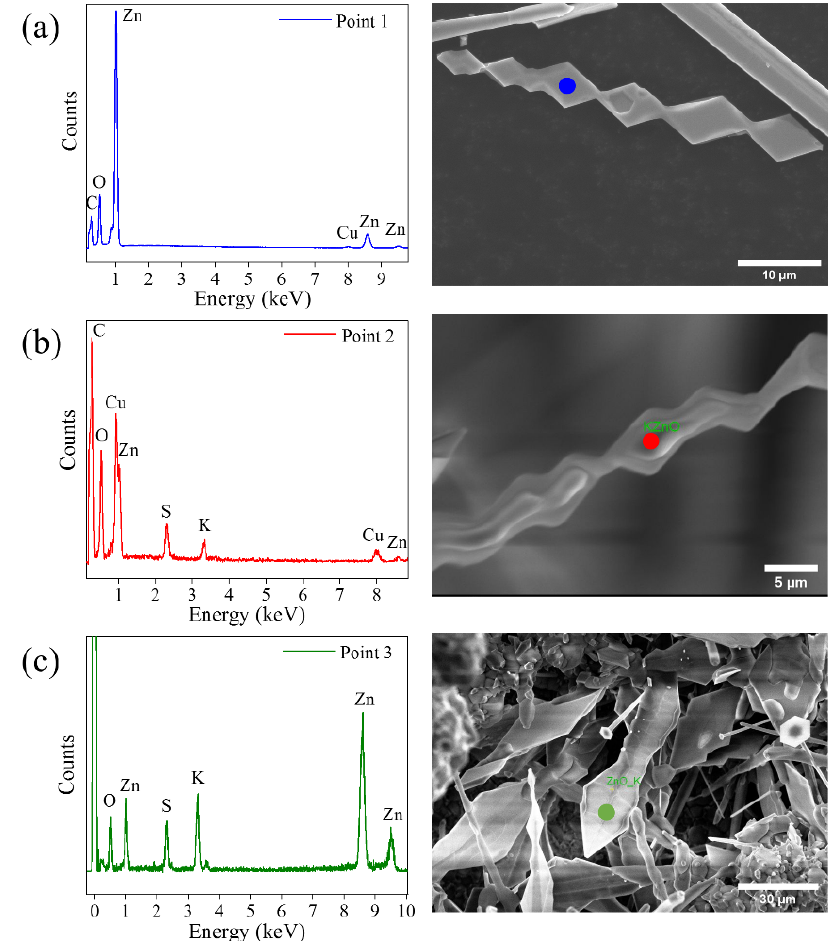
Figure 4. X-ray microanalysis on triangle-shaped structures. EDX spectrum taken on ( a ) a triangular structure without any agglomerate on the surface (blue point), ( b ) a triangular structure on which a second material has begun to grow (red point) and ( c ) a triangular structure (also shown in Figure 3c) with a slightly different morphology than those analyzed in ( a , b ) (green point).